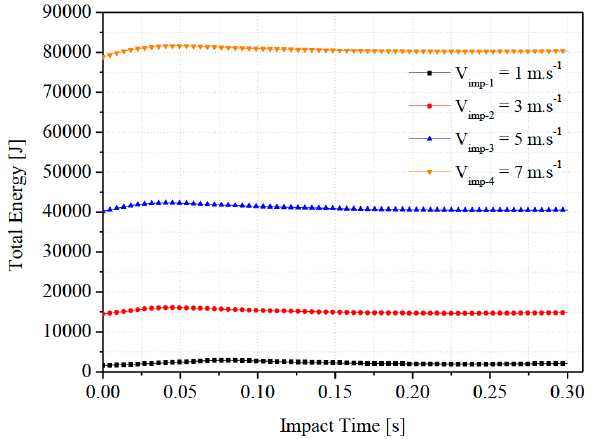
Figure 8: Total energy occurred during the container’s collision with the ship